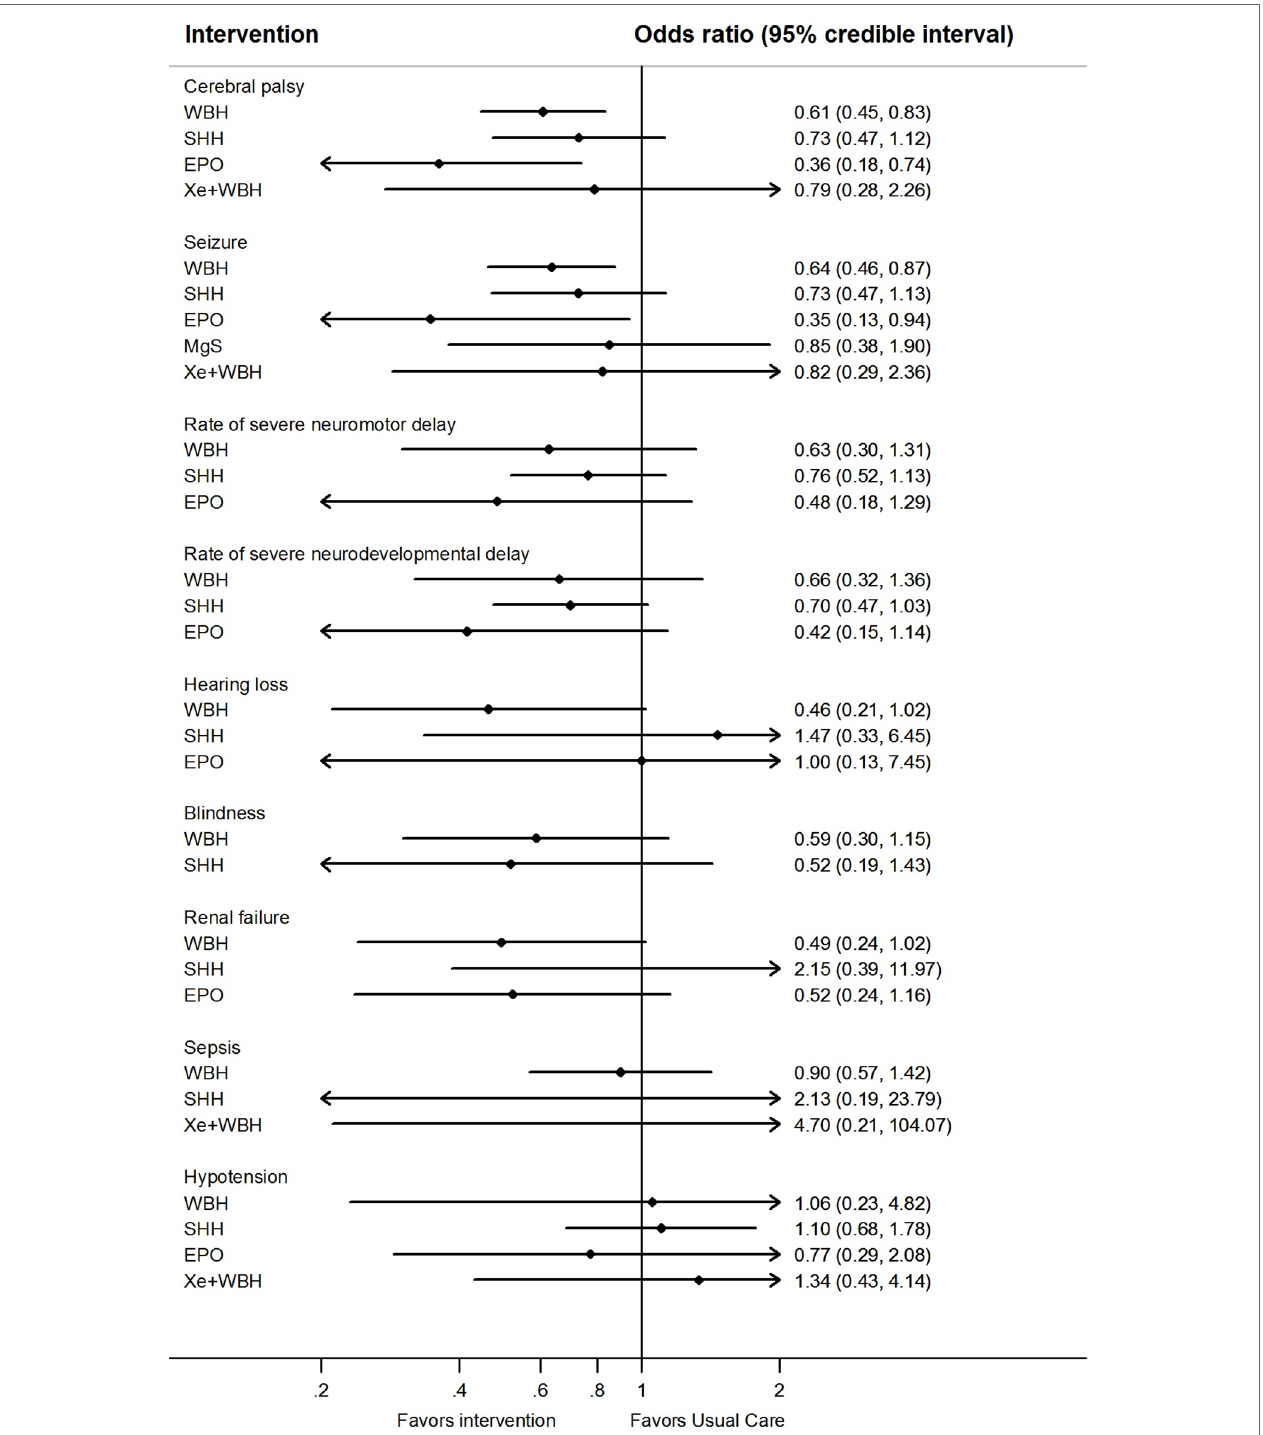
FIGURE 3 | Network meta-analysis forest plots for each treatment versus usual care on secondary outcomes. Each rhombus represents the summary treatment effect estimated in the network meta-analysis on the odds ratio (OR) scale. The black horizontal lines represent the credible intervals (CrI) for the summary treatment effects; an odds ratio > 1 suggests that usual care is more effective to reduce the risk of mortality, whereas an OR < 1 suggests that the comparable treatment is better. The vertical blue line corresponds to an OR =